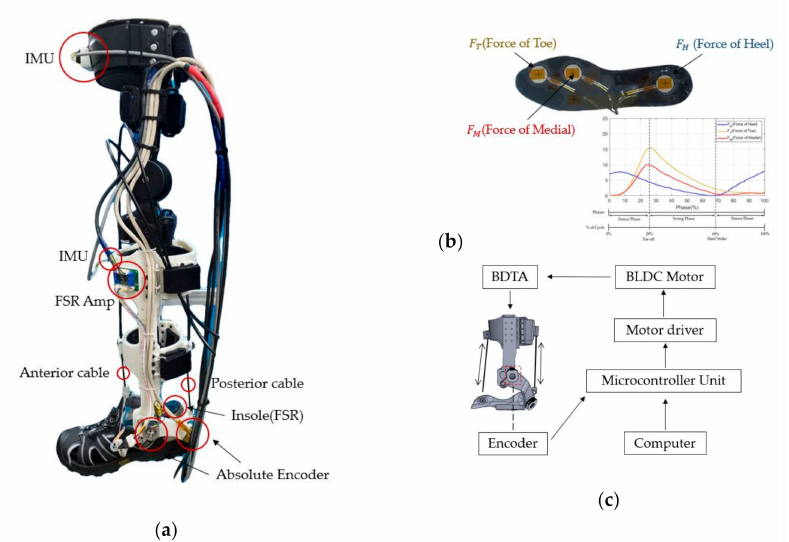
Figure 11. Overall 2DoF ankle exoskeleton robot: ( a ) sensor location attached to the exoskeleton robot (encoder, inertial measurement unit (IMU), force-sensing resistor (FSR)); ( b ) foot sensor for measuring the gait step; ( c ) a schematic representation of the experimental